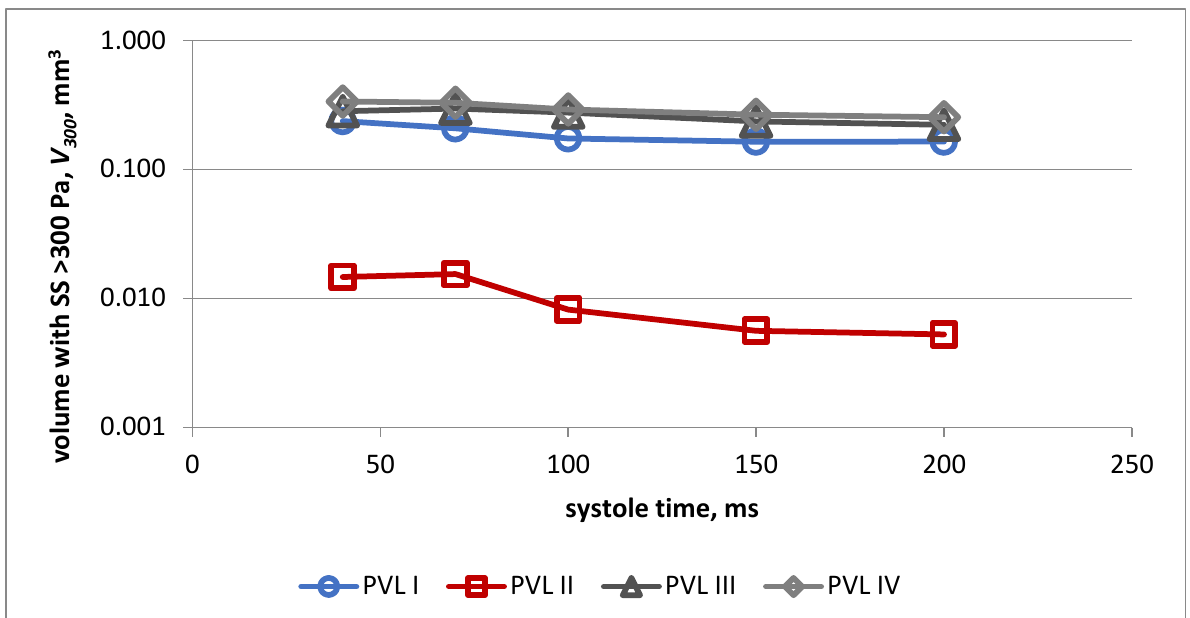
Figure 10. Volume of the PVL channel in which shear stress exceeded 300 Pa during systole for all PVL models.